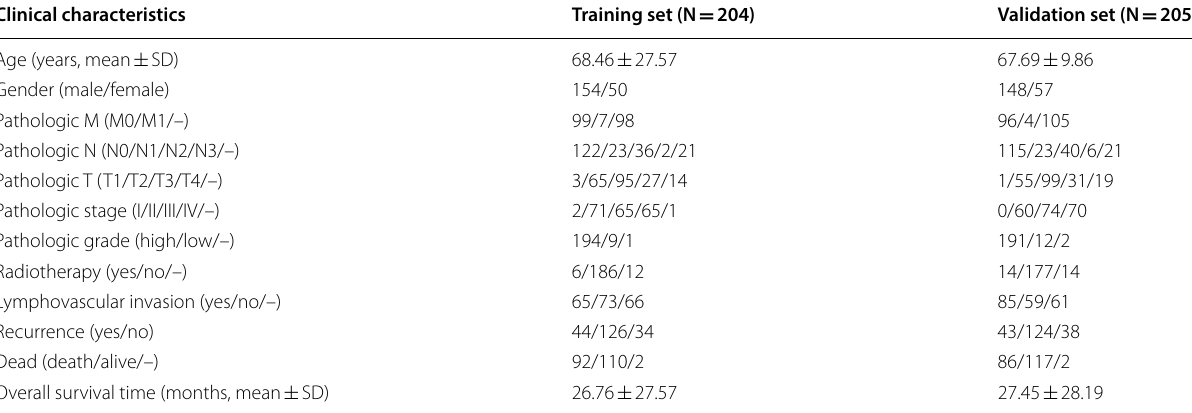
M distant metastases, N regional lymph node, T tumor size